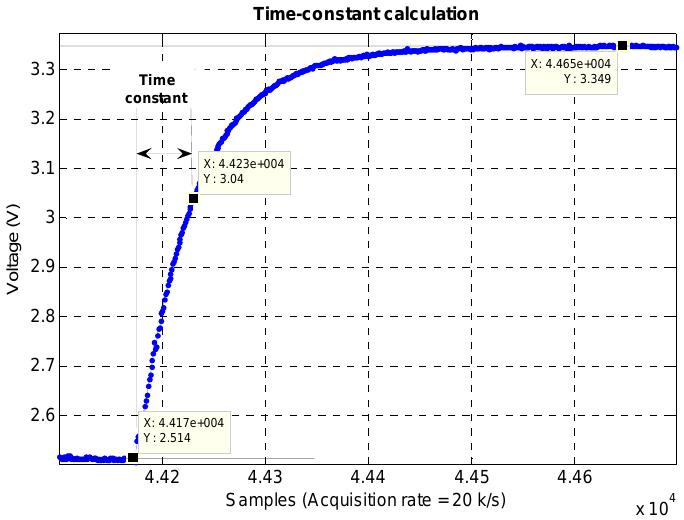
Figure 17. Experimental determination of time-constant of the accelerometer hardware